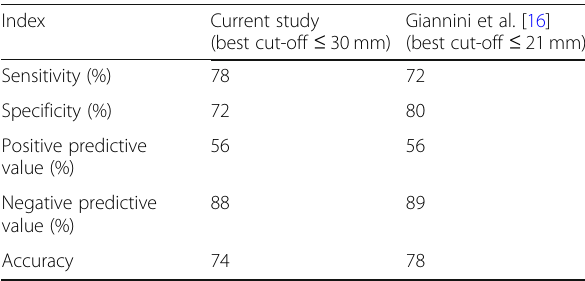
Table 3 Comparison between the diagnostic performance obtained in the current study and those obtained in the previous study by Giannini et al.